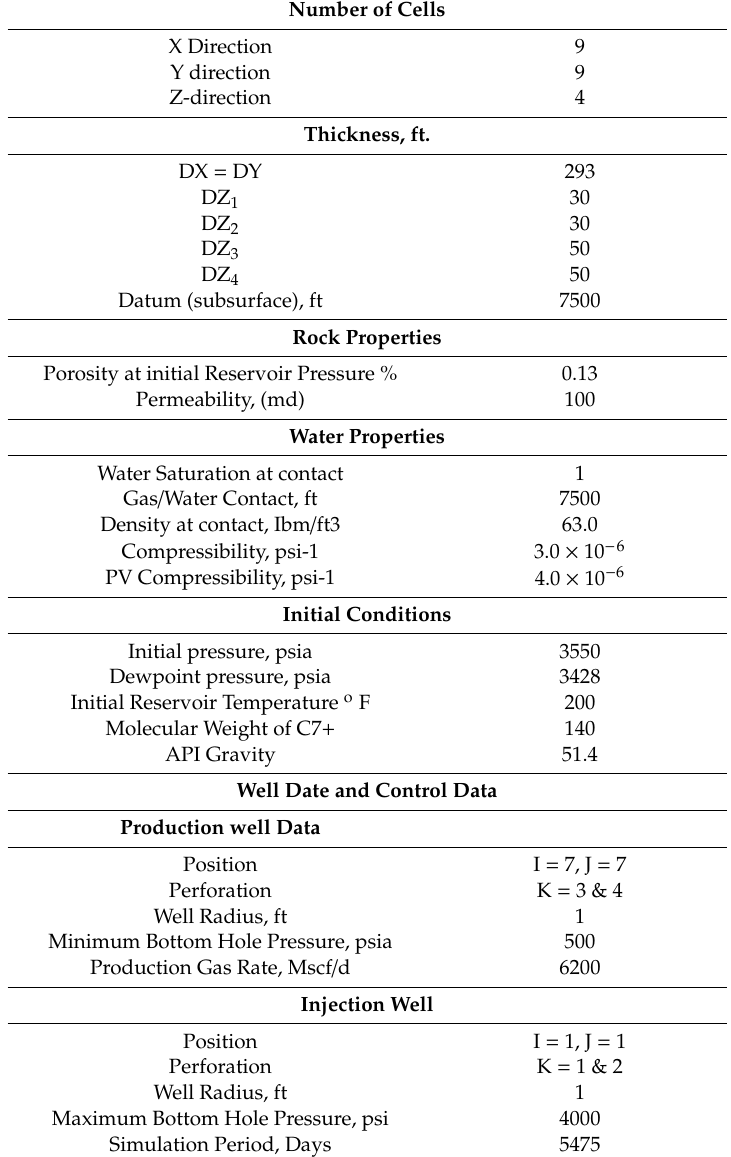
Table 1. Reservoir rock and Fluid properties adopted from Kenyon and Behie 1987 [29].